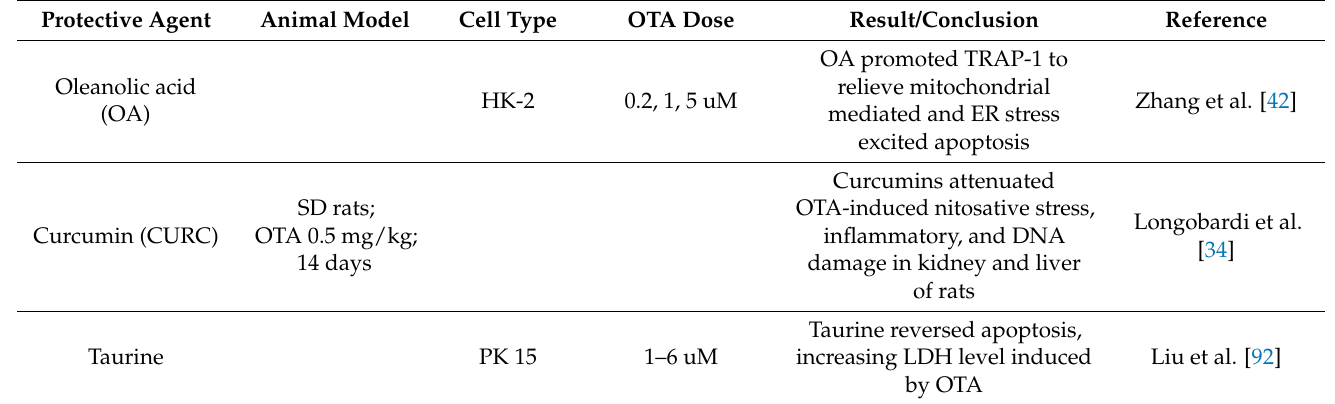
Table 3. Prevention of OTA-induced nephrotoxicity